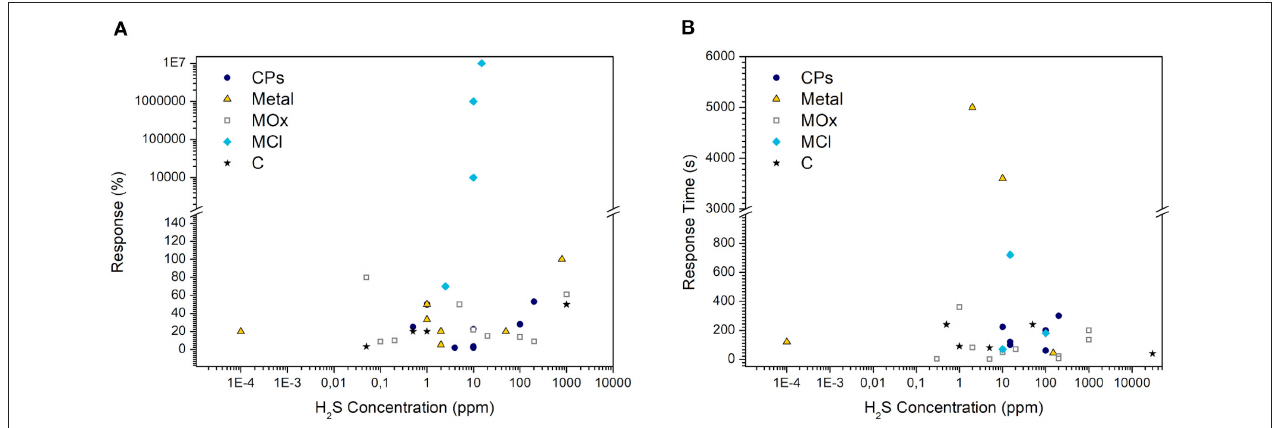
FIGURE 4 | (A) Relative responses of different materials at the lowest H 2 S concentration tested. The relative response is defined as ( R g -R 0 )* 100/R 0 , where R g and R 0 correspond to the resistance of the sensor in H 2 S and in the reference medium (air or nitrogen). It has been directly extracted or calculated from the papers presented in Supplementary Tables 1–4 . (B) Response times of different materials directly extracted from the literature. Metal, MOx, MCl, and C refer to hybrid composites based on conductive polymers (CPs) mixed with noble metal particles and metal-oxide, metal-chloride, and carbon-based items, respectively.